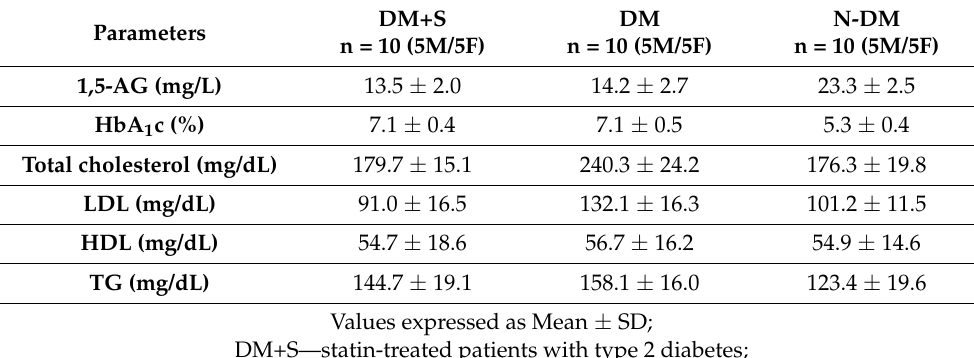
Table 1. Baseline metabolic characteristic of all